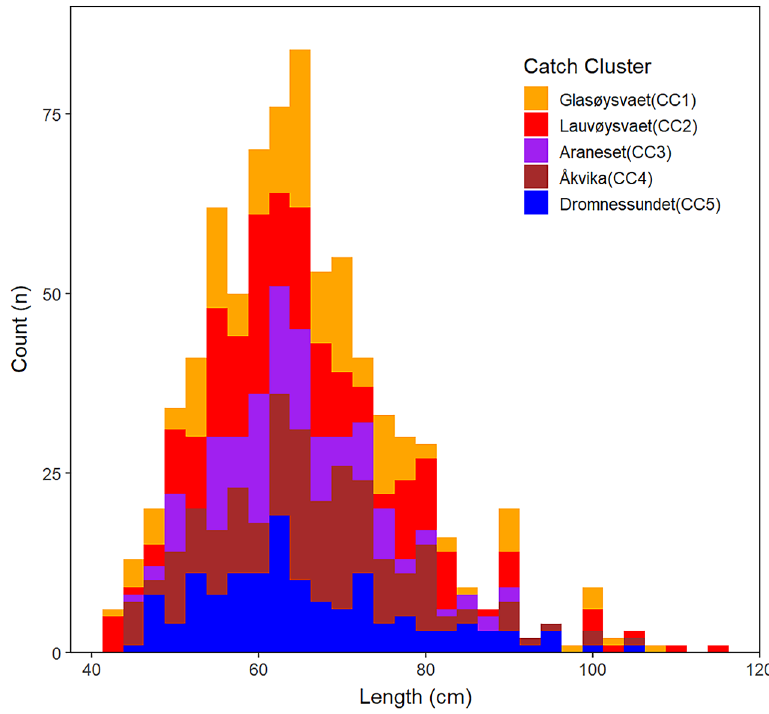
Fig. 2. Size of cod from the different catch clusters (CCs)